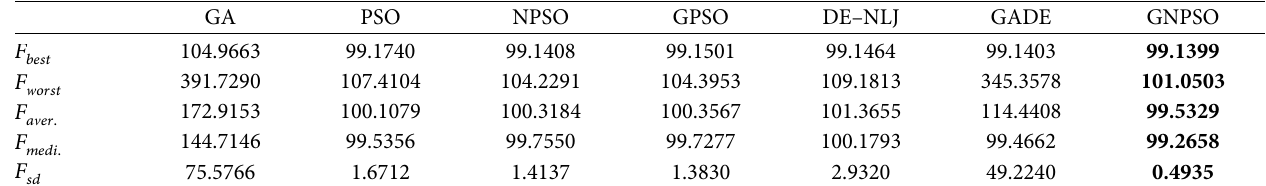
The bold values mean the best values among all the algorithms.